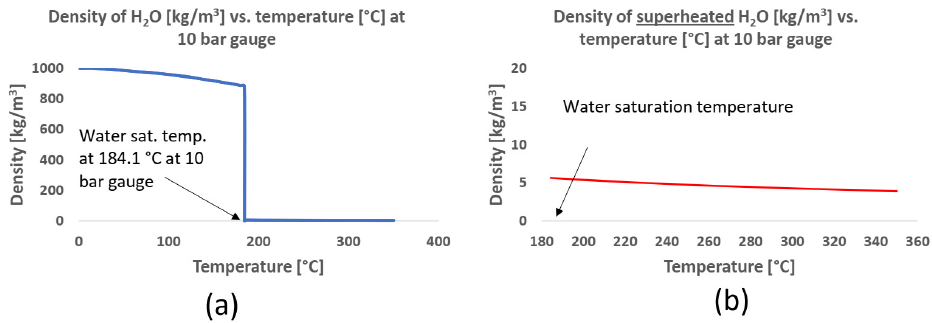
Figure 1. Density of pure H 2 O at 10 bar gauge from ( a ) 0 to 350 °C and ( b ) at superheated condi- (>184.1 ◦ tions (>184.1 °C).